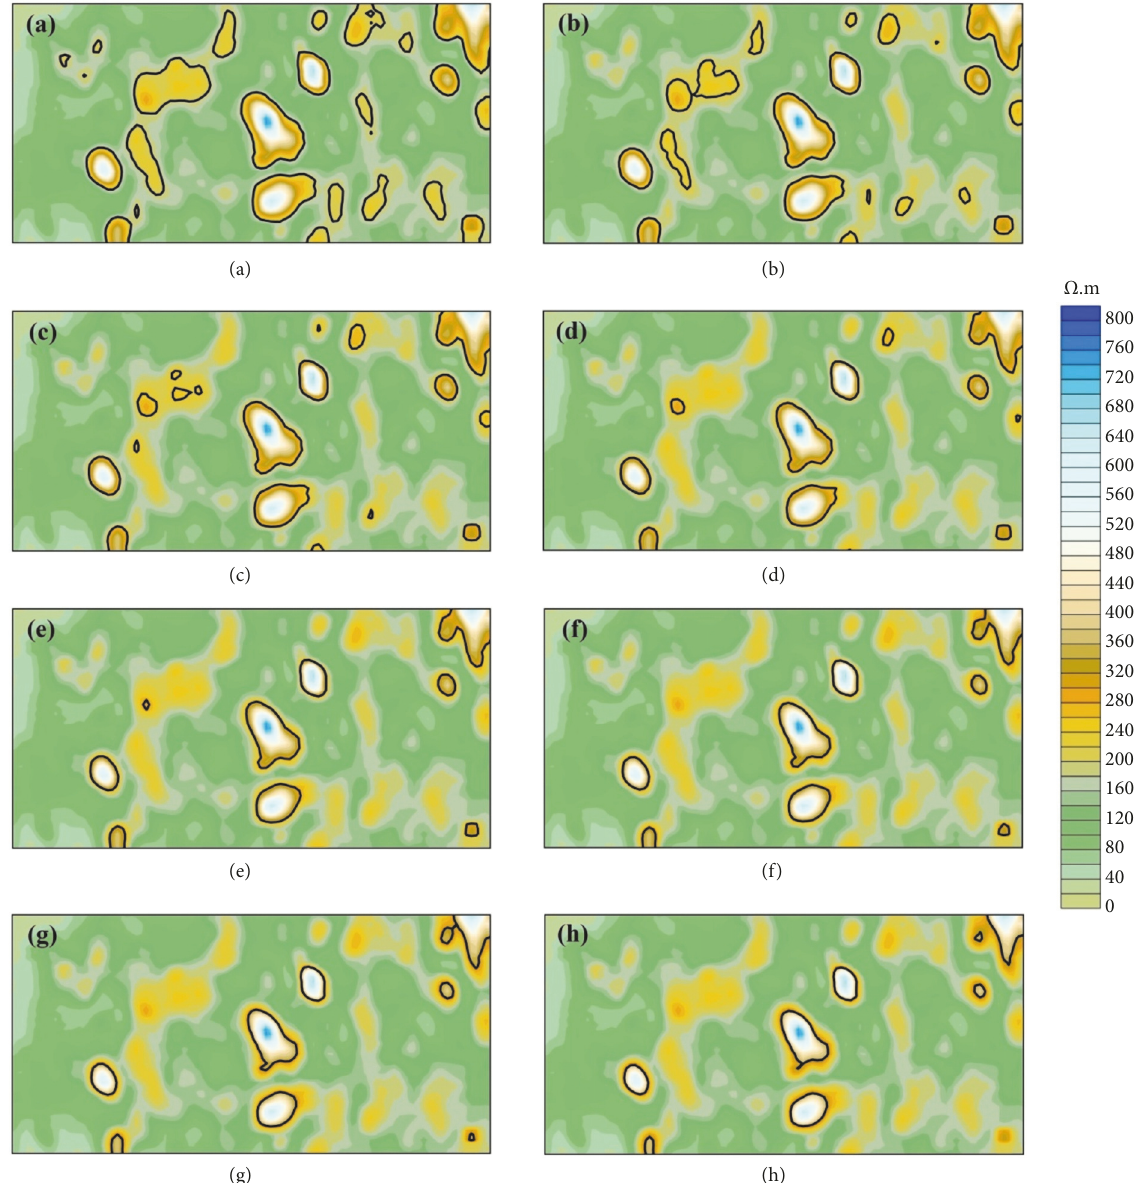
Figure 6: Comparative maps showing the geographical distribution pattern of apparent resistivity anomalies of disturbances across the study area. The cutofffrequencies (cid:2) a . r used are, respectively, the following: (a) (cid:2) a . r = 200 Ω .m, (b) (cid:2) a . r = 220 Ω .m, (c) (cid:2) a . r = 240 Ω .m, (d) (cid:2) a . r = 260 Ω .m, (e) (cid:2) a . r = 280 Ω .m, (f) (cid:2) a . r = 300 Ω .m, (g) (cid:2) a . r = 320 Ω .m, and (h) (cid:2) a . r = 340 Ω .m.